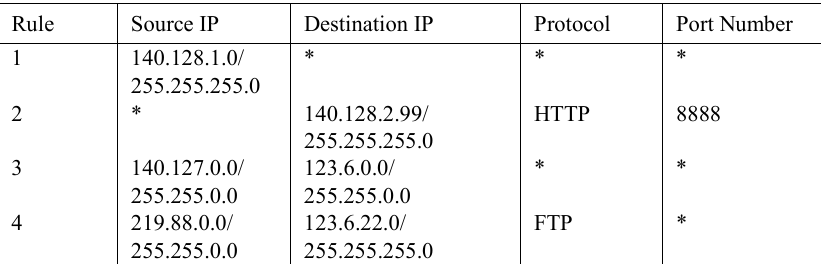
Table 2. Packet filtering